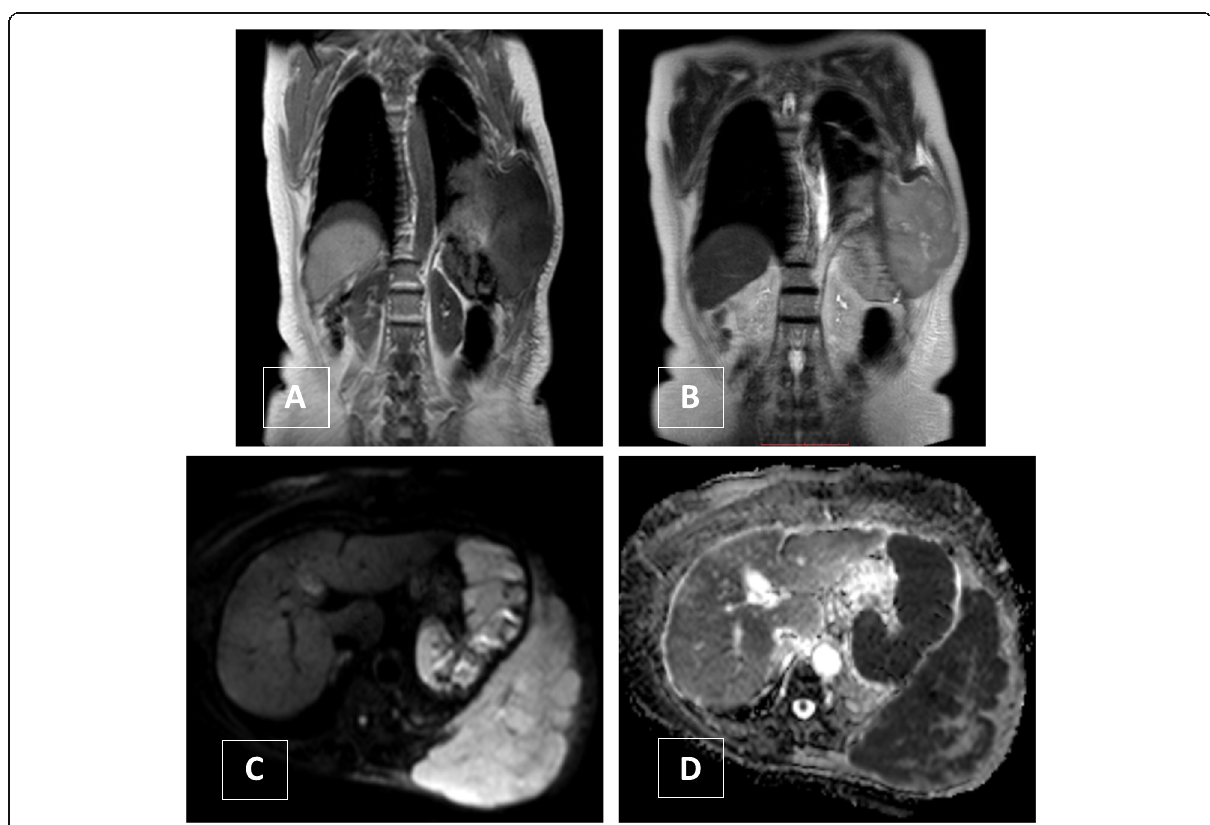
Fig. 1 A 64-year-old female patient presented with progressive pain and swelling at the left lower chest wall. MRI chest wall shows an ill-defined soft tissue mass lesion at the lower left lateral chest wall infiltrating the chest wall, eliciting low signal intensity in T1WI ( a ), intermediate to low signal intensity in T2 WI ( b ), and restricted diffusion in the form of high signal in diffusion ( c ) and low signal in ADC map ( d ). The ADC value was 0.5 ± 0.02 × 10 − 3 mm 2 /s, and the mass was pathologically proven to be a large B cell non-Hodgkin